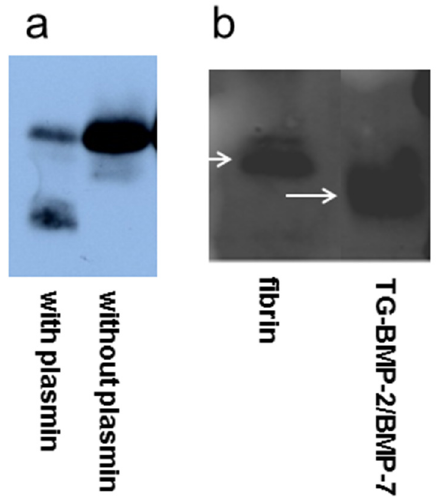
Figure 3. Functionality of TG-BMP-2/BMP-7 heterodimer indicated by probing BMP-2 ( a ) TG-BMP-2/BMP-7 was incubated with plasmin or only buffer. Plasmin cleaves the TG-BMP-2. ( b ) The heterodimer alone or contained in a fibrin gel was incubated with trypsin. Lower mobility of TG-BMP-2/BMP-7 in the fibrin gel indicates covalent